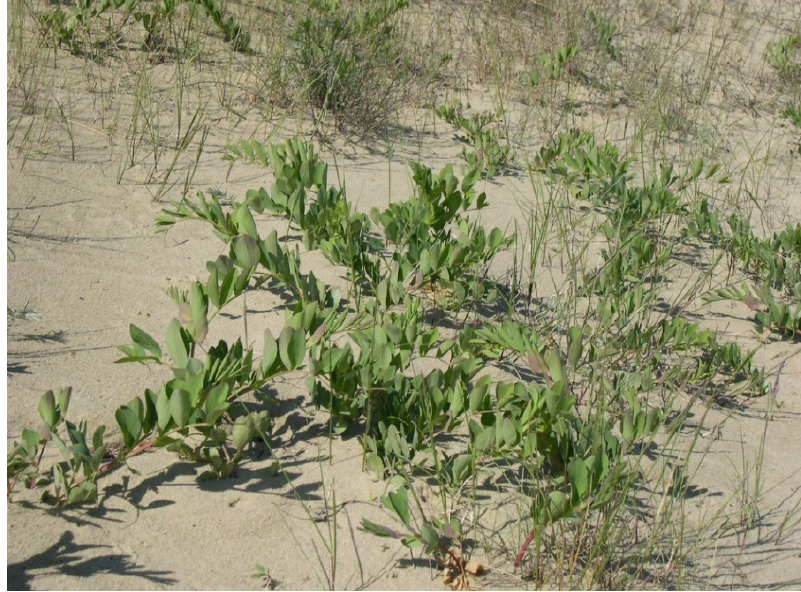
Figure 9. Beach pea (leeward side of the foredune). Phenological state: vegetative (photo by the authors). Figure9. Beachpea(leewardsideoftheforedune). Phenologicalstate: